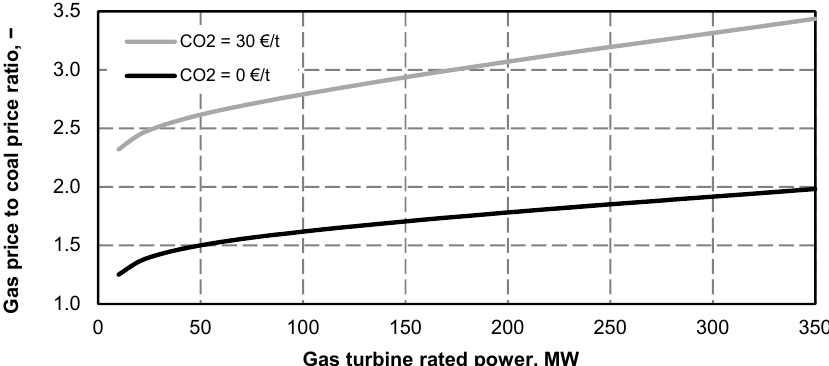
Figure 43. The ratio of unit gas price to unit coal price providing the viability of adding the superstructure of gas and single-pressure recovery boiler as a function of gas turbine rated power ( e c = 10.0 PLN/GJ).